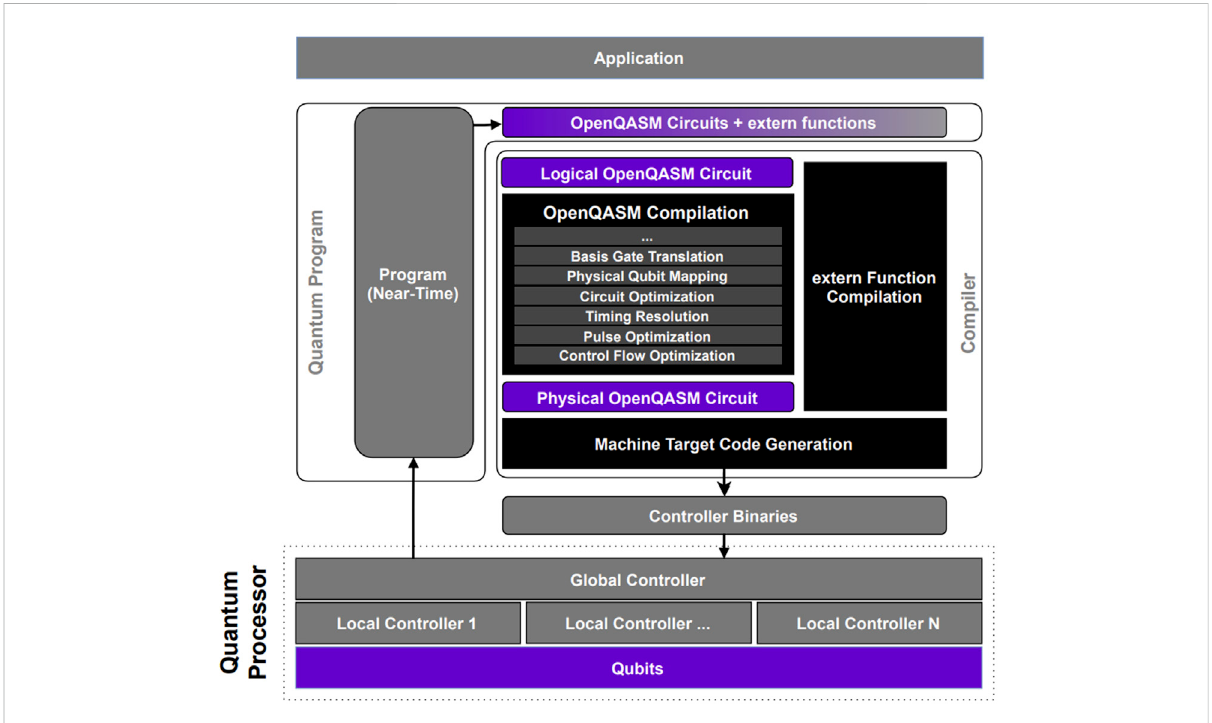
FIGURE 3 The compilation and execution model of a quantum program, and OpenQASM ’ s place in the fl ow. An OpenQASM compiler can transform and optimize all aspects of thecircuitsdescribed with the intermediate representation (IR),including basis gates used, qubit mapping, timing, pulses,